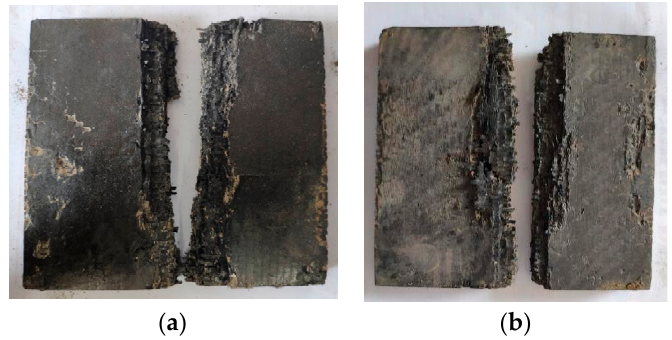
Figure 6. Results of shaped cutting test. ( a ) 15 mm; ( b ) 25 mm.